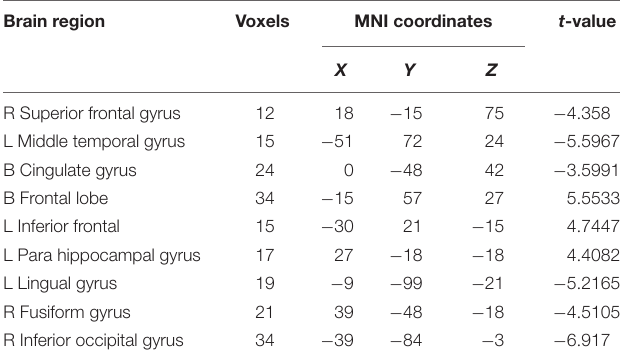
Frontiers in Human Neuroscience |